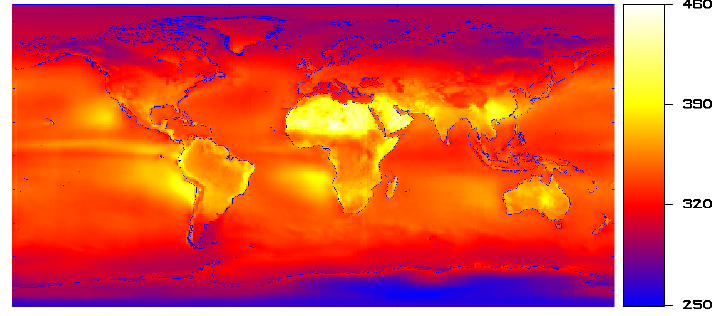
Figure 3. The 10-year mean CERES EBAF Total Outgoing